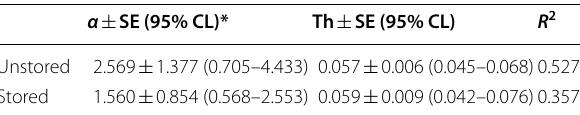
Table 2 Attack rate ( α ), handling time (Th), and standard error values of the random parasitoid equation for adult Eretmocerus mundus obtained from unstored and eight-day-stored pupae at 10 °C degrees